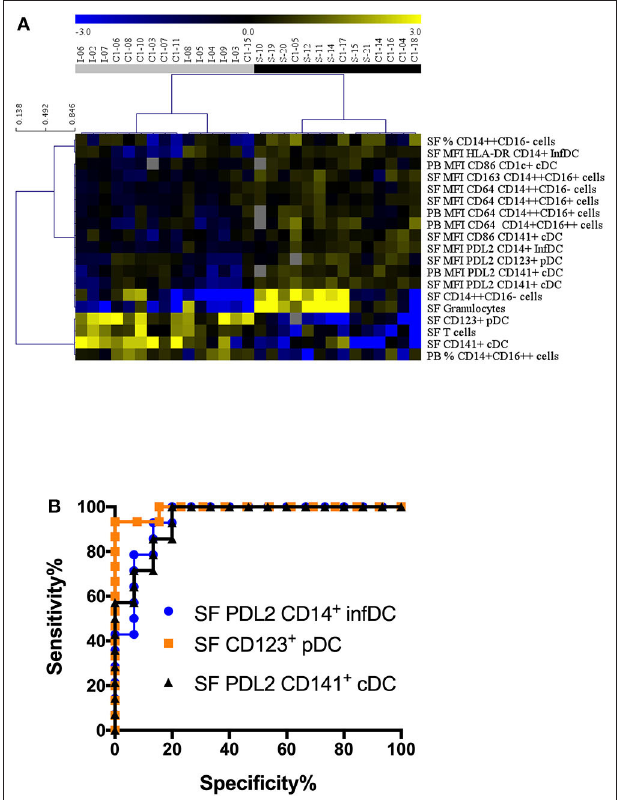
FIGURE 5 | Stratification of patients with JIA and SA based on all parameters. (A) Heatmap showing the markers (markers, rows) that were differentially represented in JIA (gray, n = 15) and SA (black, n = 14) patients (column). The dendrogram shows the results of the non-supervised hierarchical clustering analysis using an FDR cut-off of 5%. Yellow indicates relative higher expression, blue relative lower expression of the markers. (B) Receiver operating curves (ROC) for markers with AUC values >